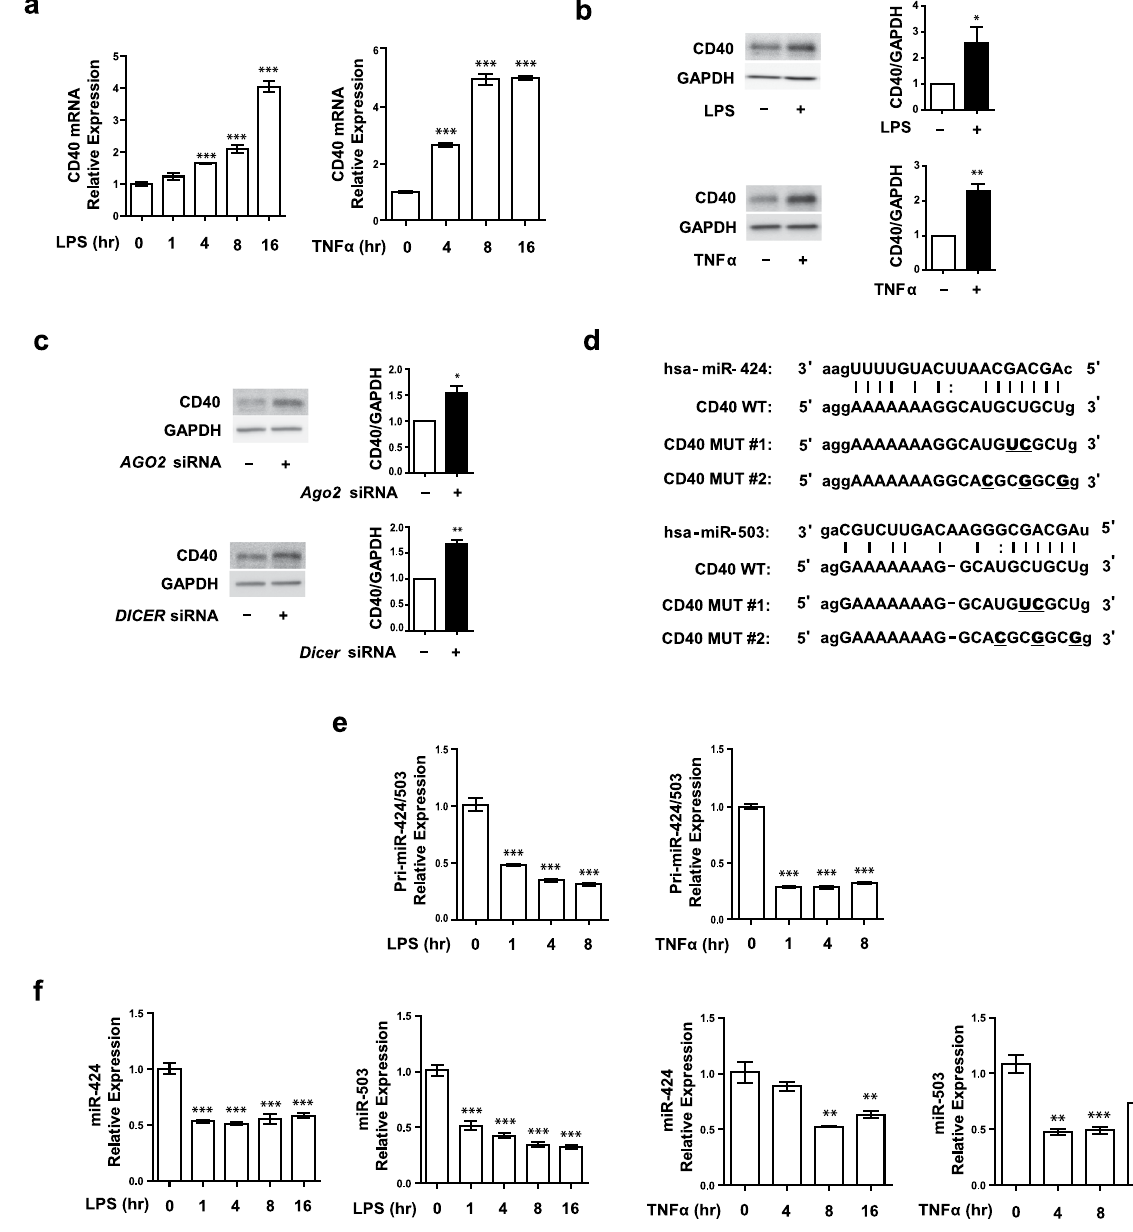
Figure 1. Pro-inflammatory stimuli upregulate CD40 and reduce miR-424 and miR-503 expression in HUVECs. ( a ) CD40 mRNA expression in response to LPS (1 μ g/ml) or TNF α (10ng/ml) in a time dependent manner. ( b ) CD40 protein expression in response to stimulation with either LPS (1 μ g/ml for 24 h) or TNF α (10ng/ml for 16 h). ( c ) CD40 protein expression in HUVECs 72 h after AGO2 or DICER siRNA transfection. ( d ) Predicted target sequences of CD40 3 ′ UTRs targeted by miR-424 and miR-503 and mutated sequences (MUT#1, #2) for disrupting miR-424 and miR-503 recognition sequence. ( e , f ) Quantitative PCR showing expression of the mature and pri forms of miR-424 and miR-503 in response to LPS (1 μ g/ml) or TNF α (10ng/ml) in a time dependent manner. ( f ) * P < 0.05, ** P < 0.01, *** P < 0.001 compared to controls. Error bars, s.e.m. Cropped gel images are shown; uncut gels are included in the Supplementary